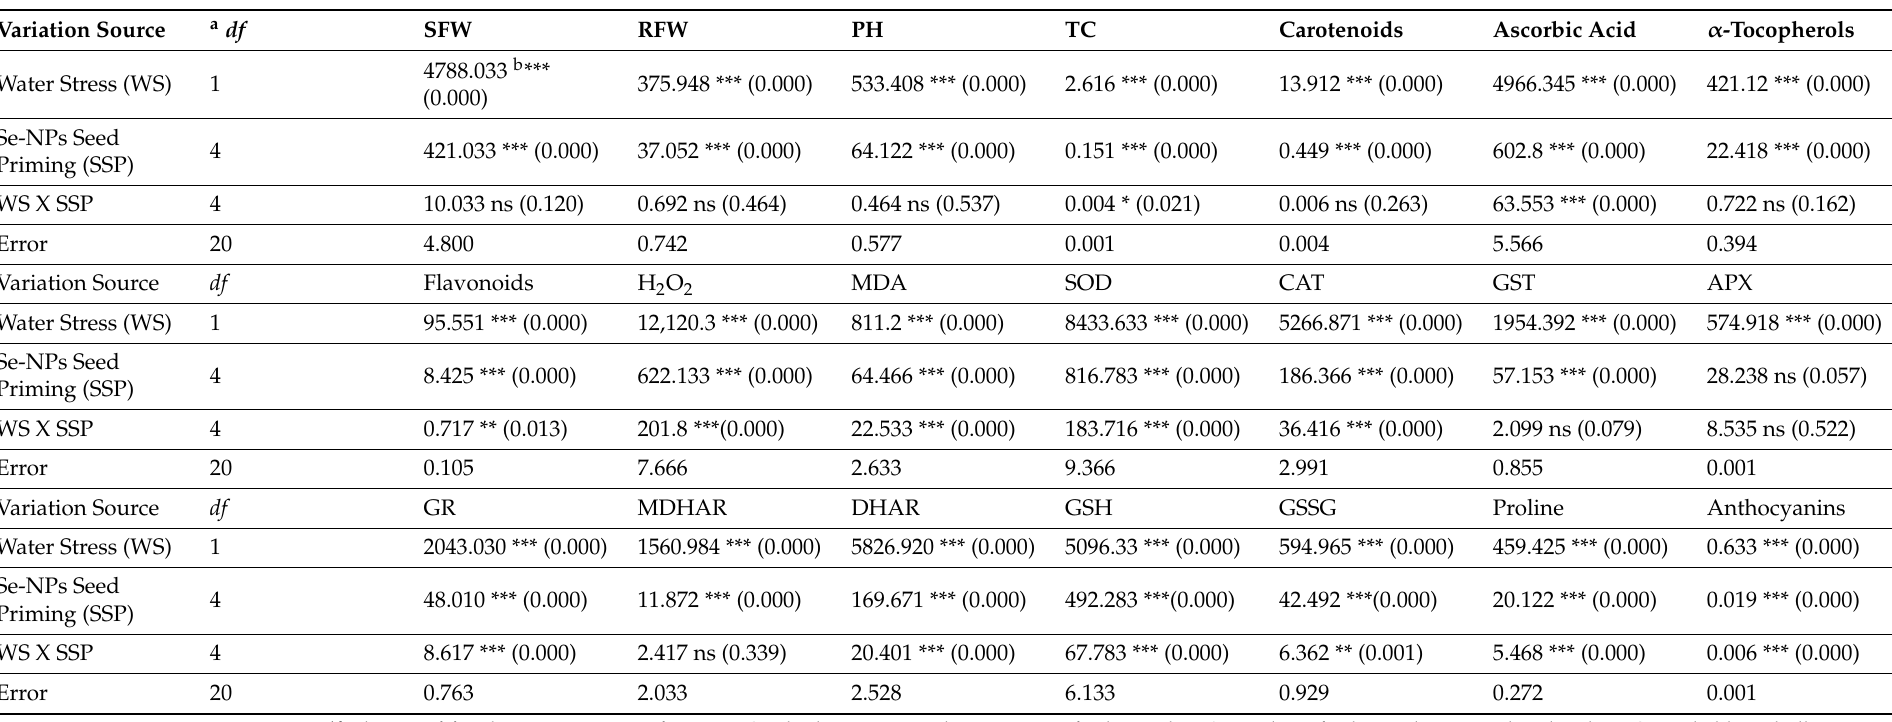
Table 1. Physiochemical parameters of tomato plants measured after seed priming using SeNPs and analyzed through ANOVA (with mean square and p